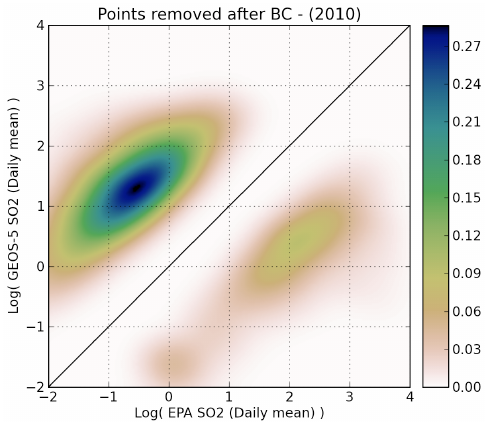
Fig. B1. Points removed after the adaptive buddy check of Dee et al. (2001) was performed on the model revised SO 2